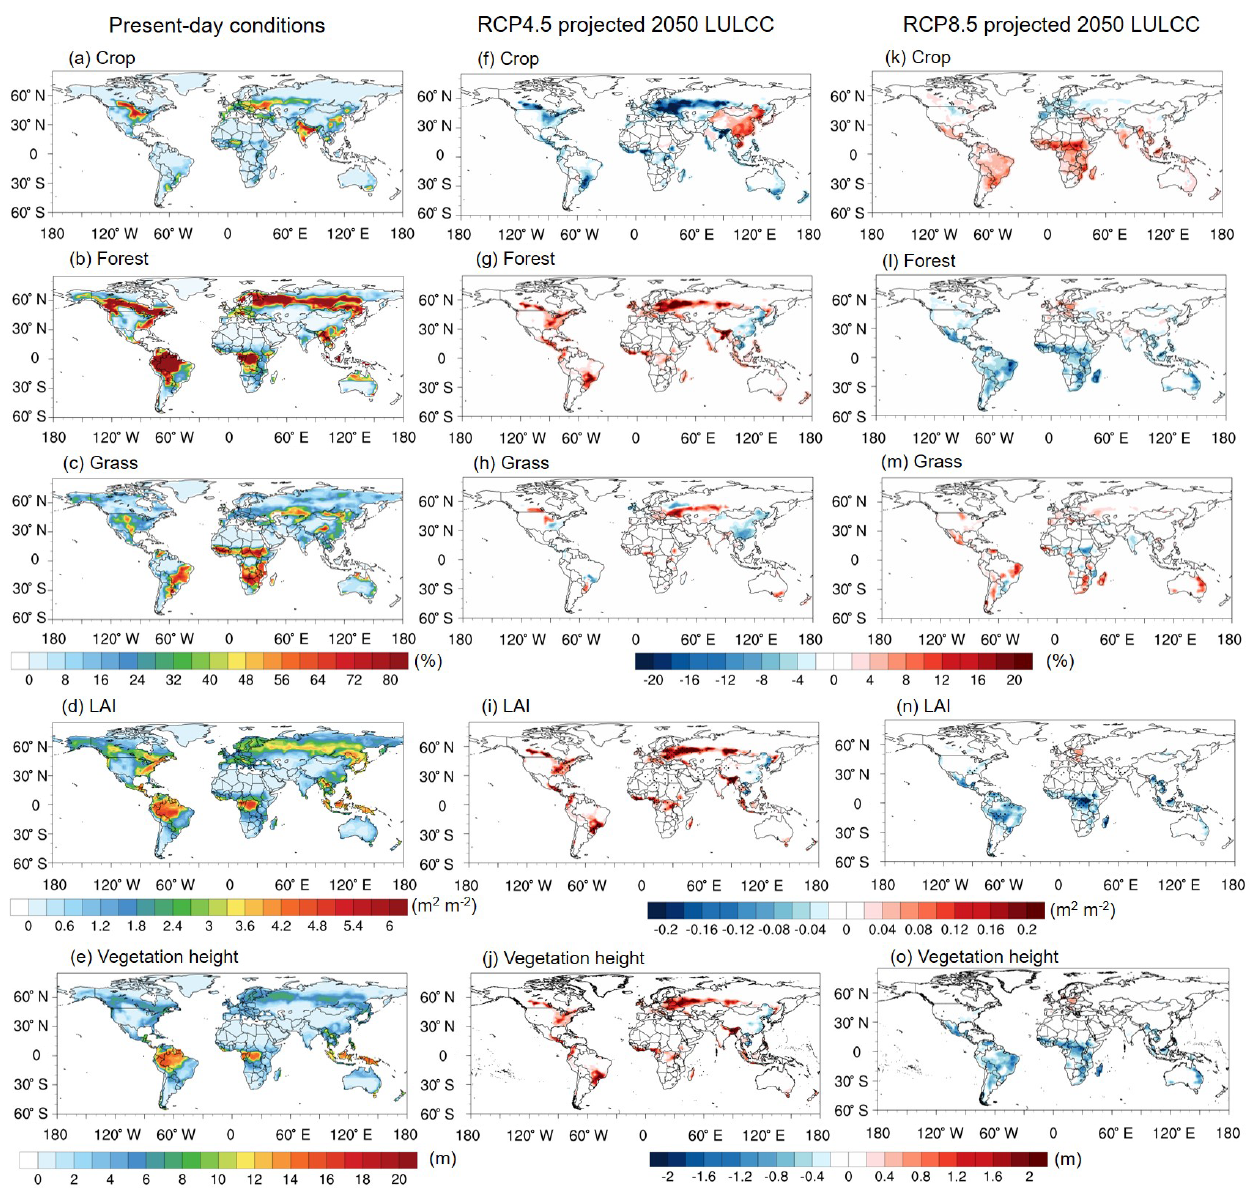
Figure 2. The present-day (2000) land use and land cover by percentage of land coverage, total leaf area index (LAI), and vegetation height (a–e) and their changes from 2000 to 2050 under RCP4.5 (f–j) and RCP8.5 (k–o) scenarios for the boreal summer (June–July– August) (units at the right side of the color bar). Plant function types (PFTs) in CESM are here grouped into three major categories: crop, forest, and grass. The treatment of vegetation including PFT fractional coverage, LAI, and vegetation height is prescribed using the SP mode of CLM4.5 in both the present-day case and future LULCC scenarios. For the future cases, PFT fractional coverage is derived according to the RCP land